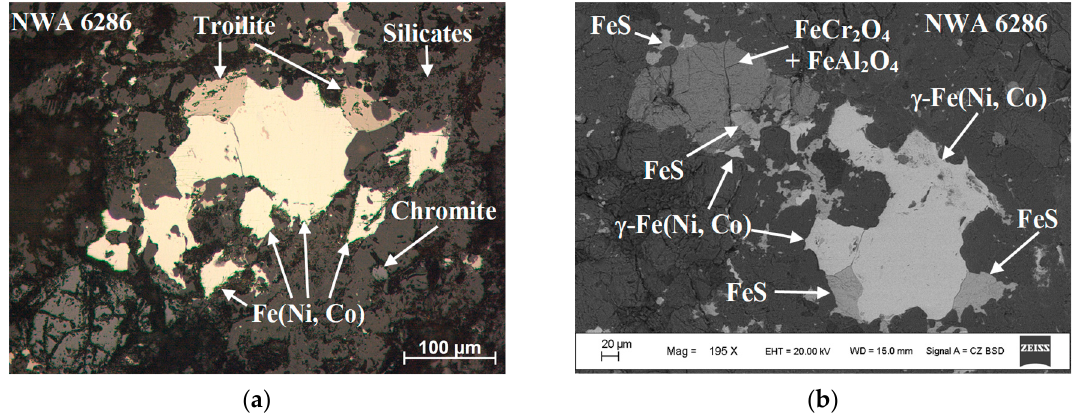
Figure 2. Microphotographs of NWA 6286 polished section obtained using: ( a ) optical microscopy; and ( b ) scanning electron microscopy. Adopted from [13].